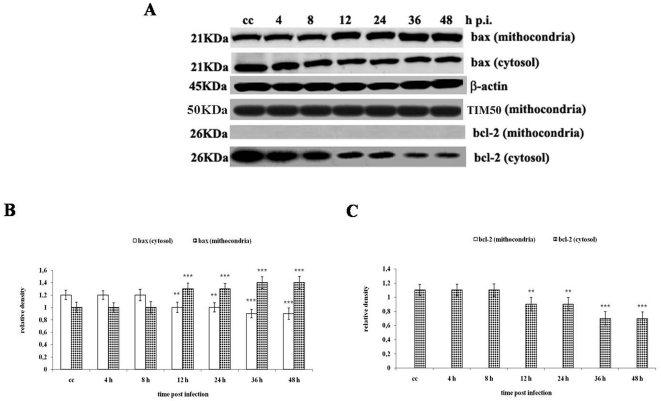
CCoV-II infection induces bax translocation into the mitochondria and bcl-2 decrease.(A) A-72 cells were mock-infected (lane cc, control cells) and CCoV-II infected (4, 8, 12, 24, 36 and 48 h p.i.). The bax and bcl-2 expression was evaluated in the cytosol and in the mitochondrial fractions during the infection; equal amounts of proteins from each sample were subjected to Western blot analysis and probed for bax and bcl-2. β-actin and TIM50 were used as a loading control. The molecular weight (KDa) of protein size standards is shown on the left hand side. Blot is representative of three separate experiments. (B) Densitometric analysis of bax and (C) of bcl-2 are shown below the blots. The bars represent the mean ± SEM of the results from three separate experiments. Significant differences between CCoV-II-infected cells and control cells are indicated by probability P. **P <0.01 and ***P <0.001.